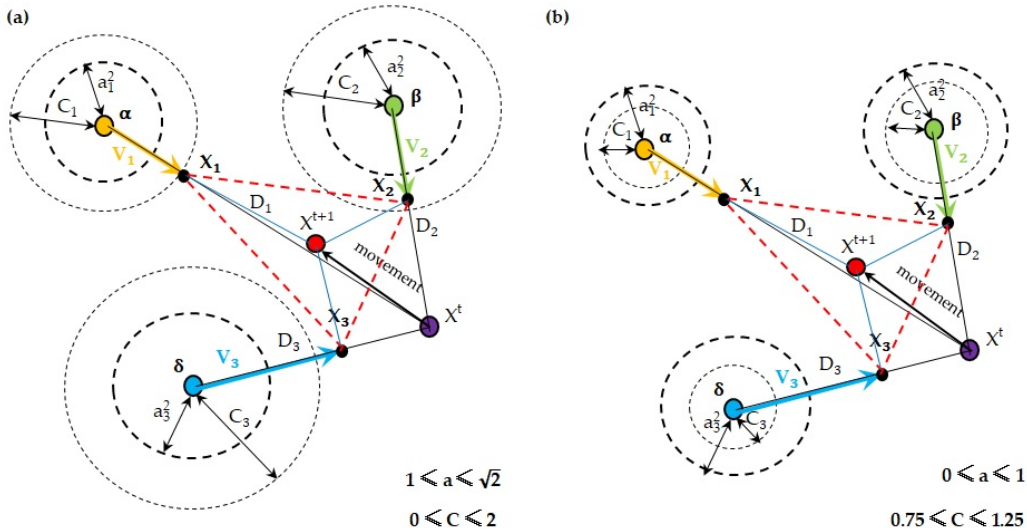
Figure 1. Movement of an exemplary omega wolf in the VAGWO during ( a ) exploration; and ( b ) exploitation.